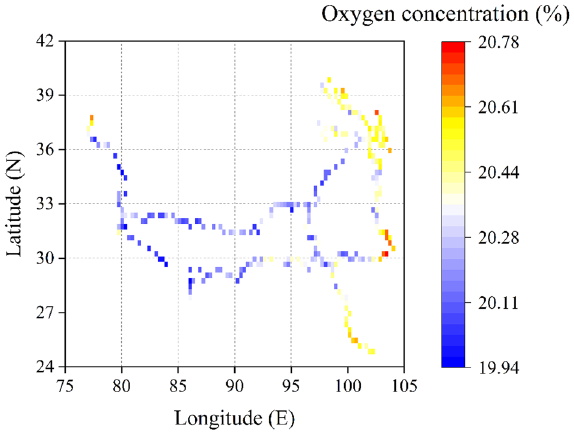
Figure 2. Spatial distribution of oxygen concentration within the QTP and its neighboring regions in the summers of 2018–2020.